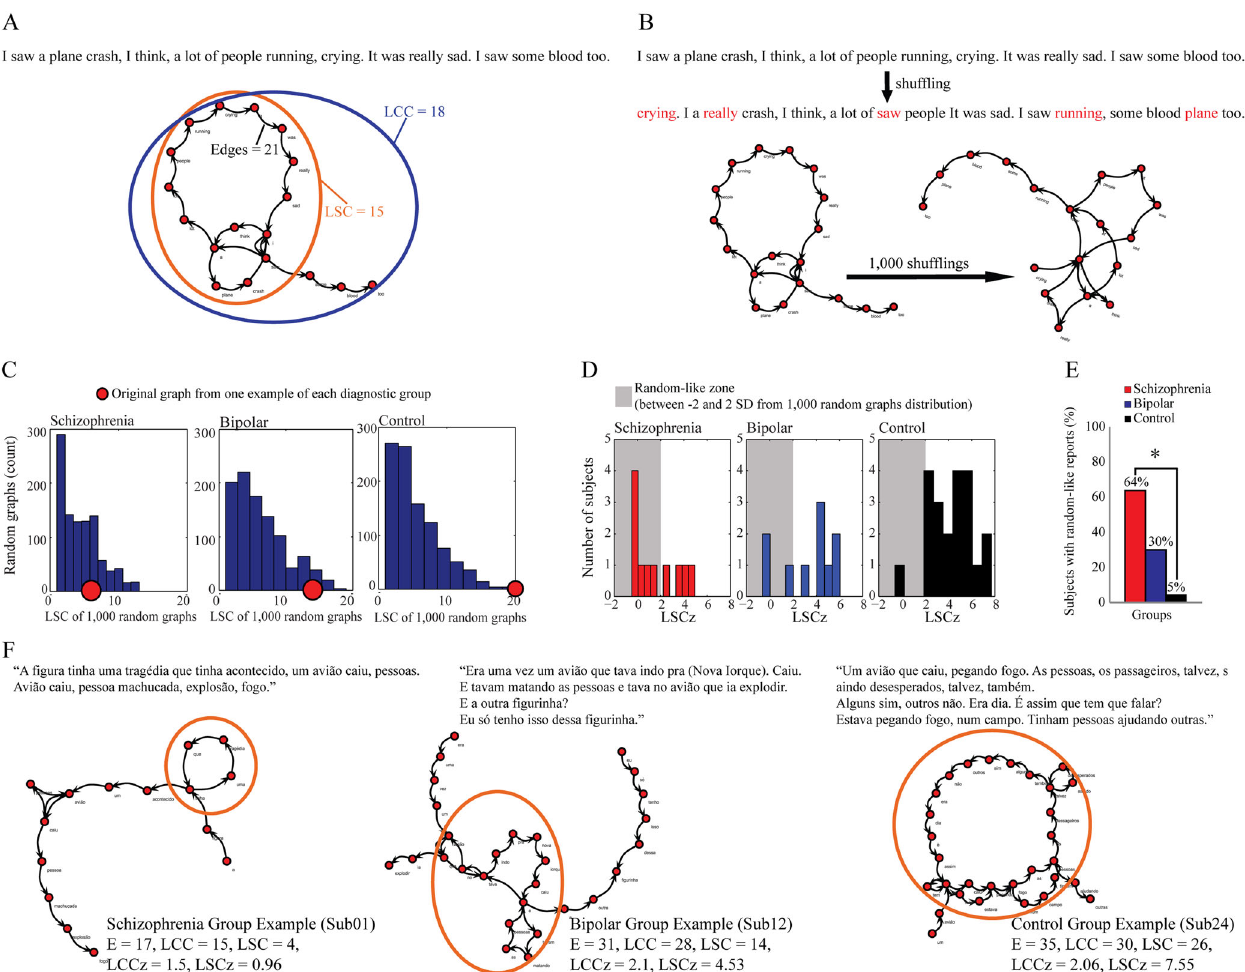
Fig. 2 Speech graph connectedness attributes and random-like connectedness in schizophrenia. a Illustrative example of a text represented as a graph, showing connectedness attributes Edges, LCC, and LSC. b Illustrative example of random graphs created from an original report. By shuf fl ing word order 1000 times, surrogated graphs maintained the same words but displayed a random word structure (displaced words in red ). c Examples of one negative image report compared to 1000 random graphs for each group. Estimation of original LSC ( red dot ) distance from a 1000 random graph distribution ( blue histogram) by z -score — LSCz. d LSCz histogram from each diagnostic group, considering as random-like speech those with LSCz = − 2 until 2 (2 standard deviation from a random graph distribution). e Percentage of random-like reports in each diagnostic group (Asterisk means p < 0.05 — χ 2 test). f Representative graphs for each group, obtained from negative image